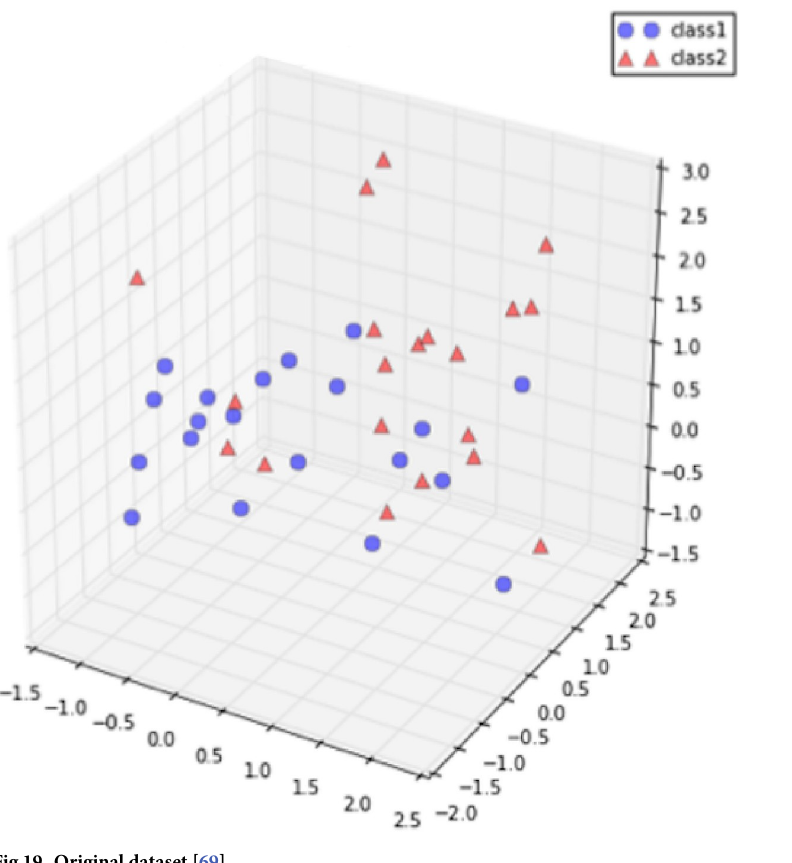
Fig 19. Original dataset